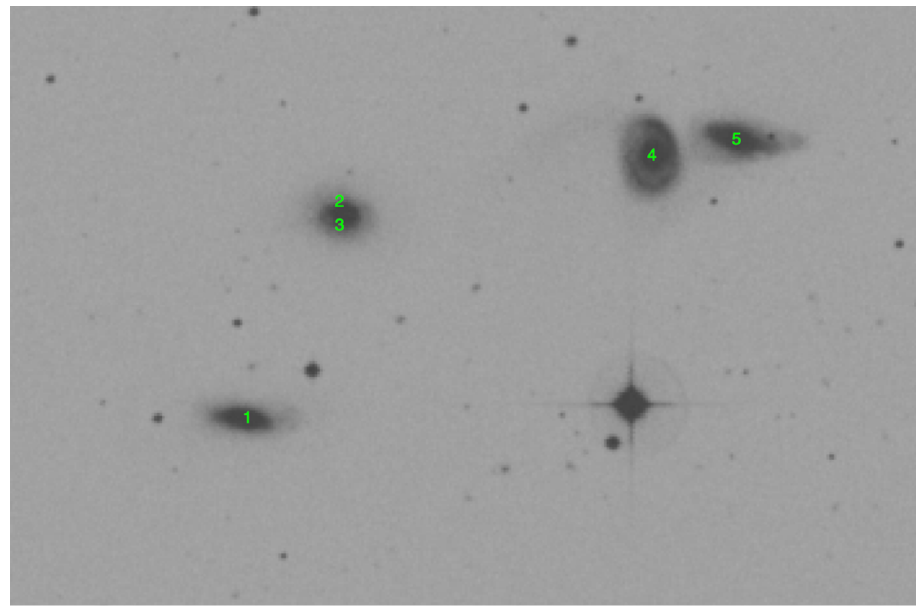
Figure 6. DSS image of HCG 16 with X-ray point sources.